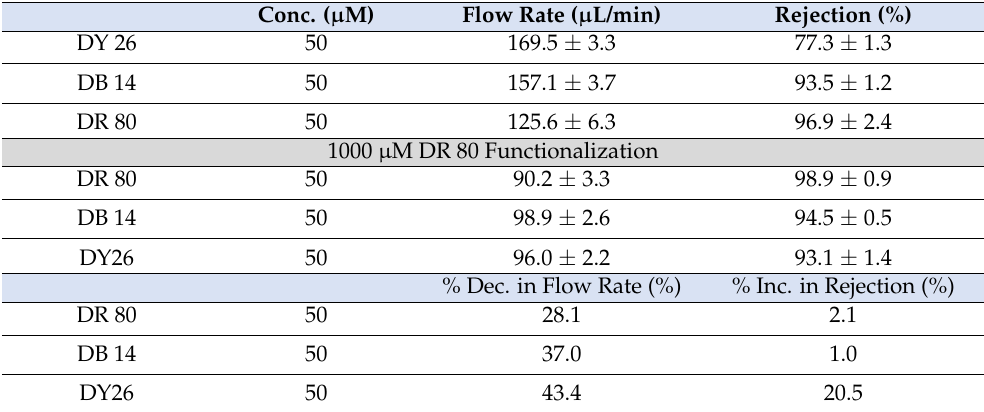
Table 2. Rejection and flow rate values for 50 µ M concentrations of direct yellow 26, direct blue 14, and direct red 80 pre- and post-azo-dye-functionalization, using direct red 80 at 1000 µ M for 35 min on a polycarbonate filter already prefunctionalized with USANP monolayers.